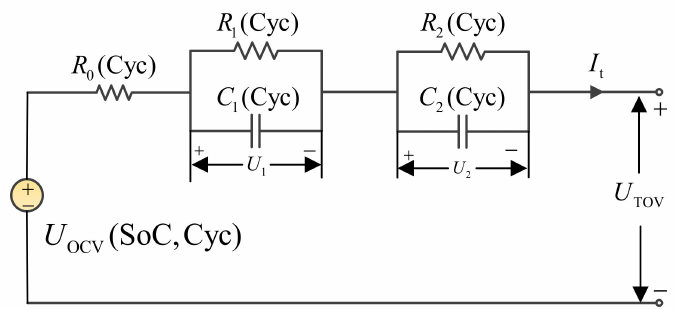
Figure 4. The schematic of battery